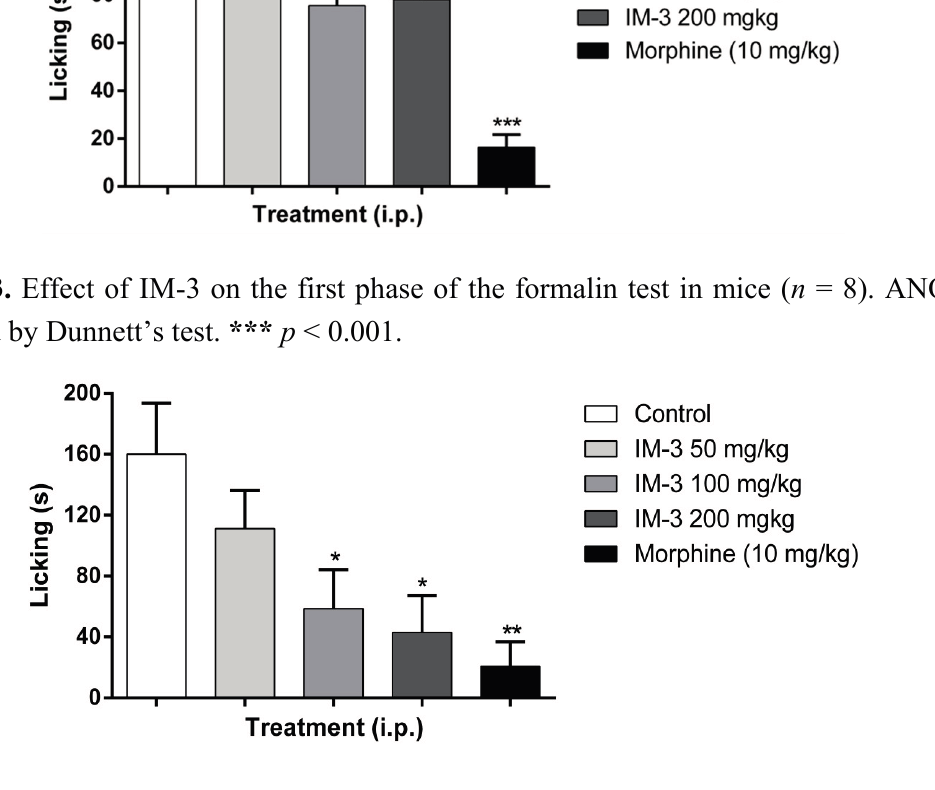
Figure 4. Effect of IM-3 on the second phase of the formalin test in mice ( n = 8). ANOVA followed by Dunnett’s test. * p < 0.05; ** p <